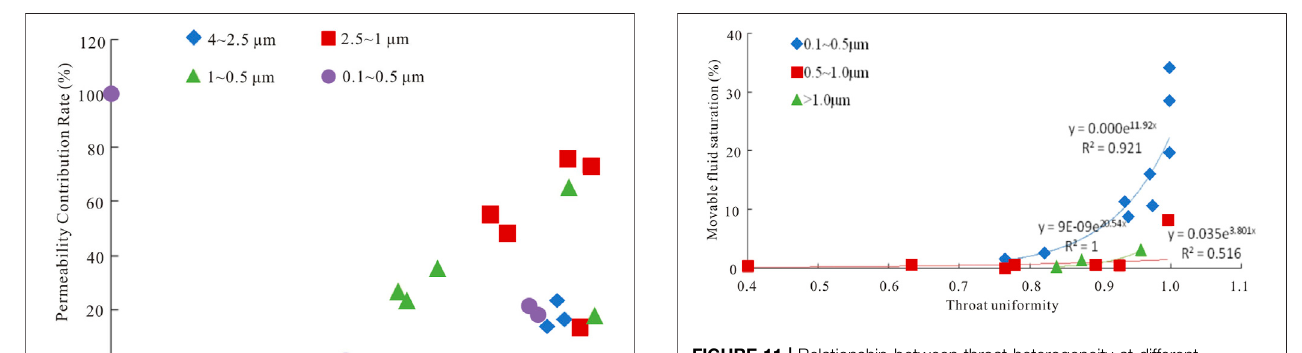
FIGURE 11 | Relationship between throat heterogeneity at different scales and movable fl uid